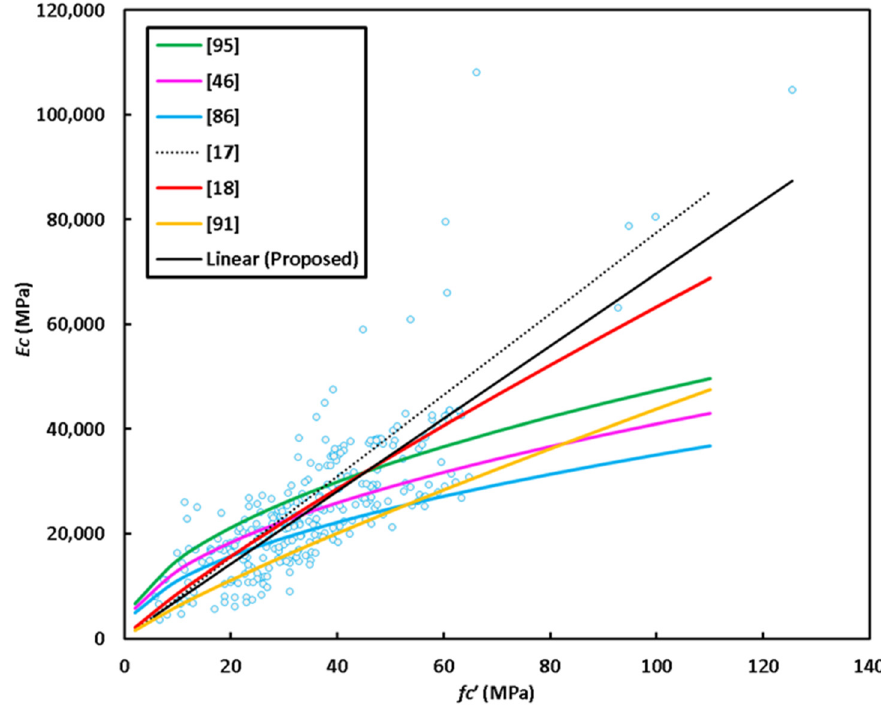
Figure 11. Elastic modulus data scatter and proposed equations.